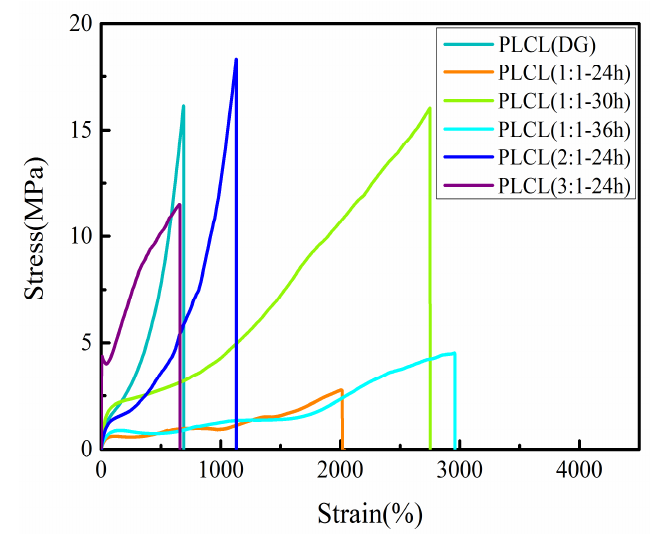
Figure 6. Stress–strain curves of the films of PLCL copolymers. Table 2. Tensile properties of the films of PLCL